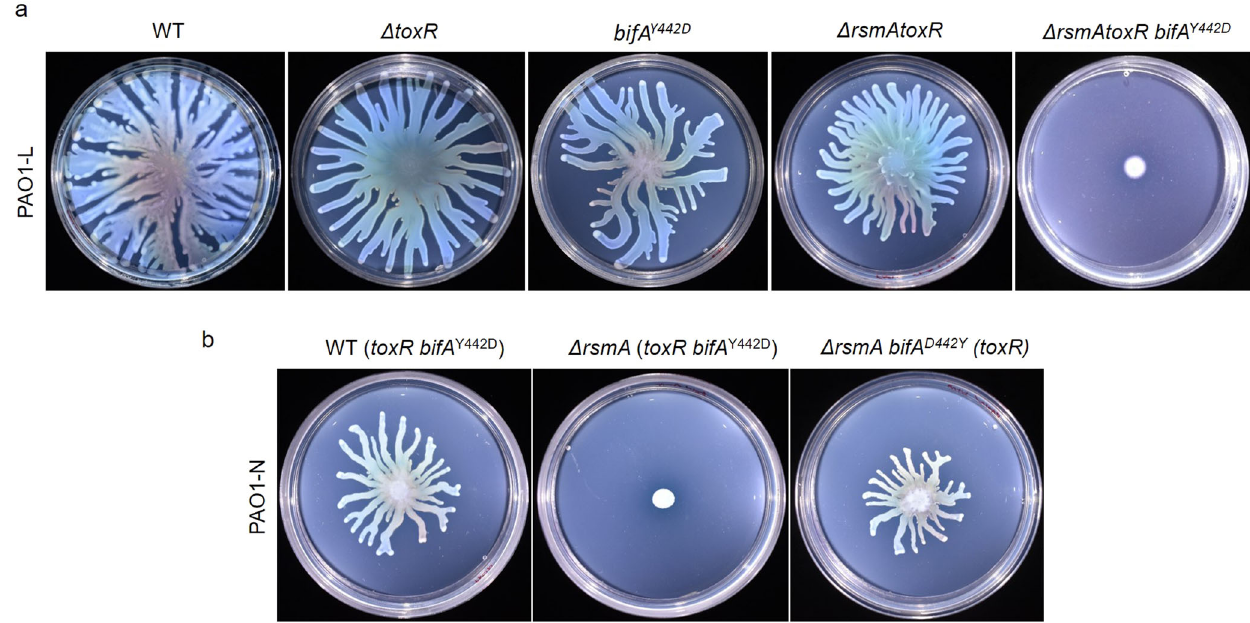
Fig. 3 Impact of rsmA , toxR , bifA mutations on swarming. Swarming motilities of PAO1-L a and PAO1-N b WT strains and their corresponding rsmA , toxR and bifA mutants, assayed over a period of 16 h at 37